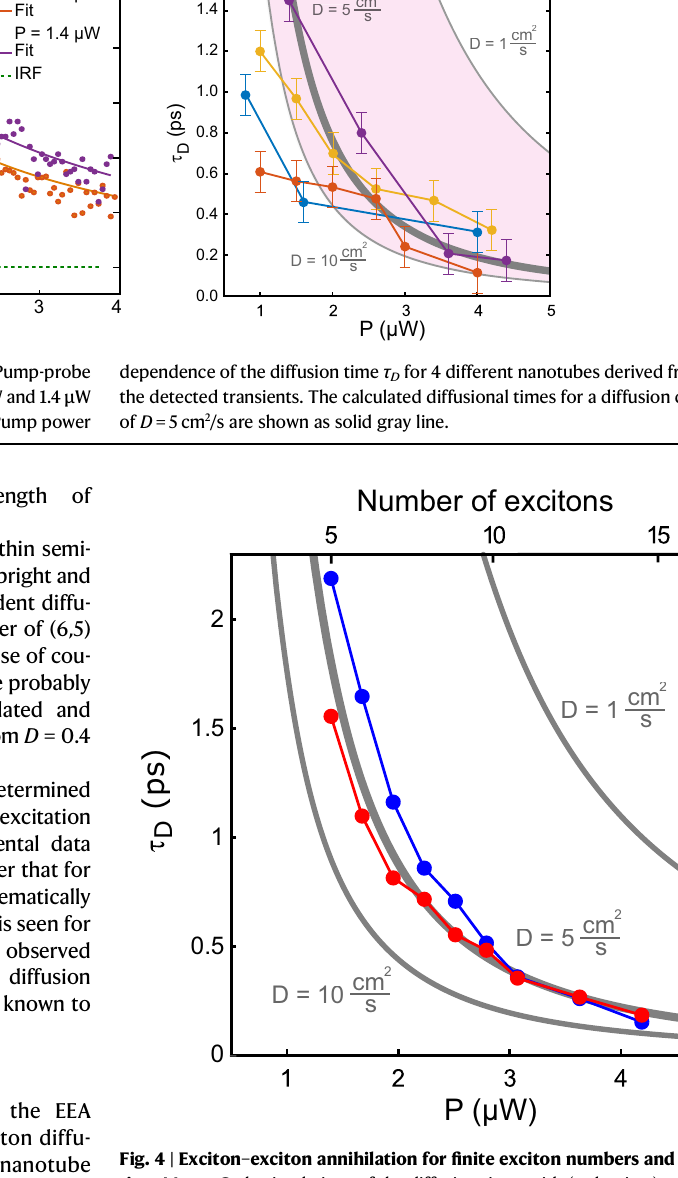
Fig. 4 | Exciton – exciton annihilation for fi nite exciton numbers and localiza- tion. Monte-Carlo simulations of the diffusion times with (red points) and without (blue points) exciton localization and a diffusion coef fi cient of D =5cm 2 /s. Analyti- callycalculateddiffusiontimesfor D =1,5and10cm 2 /sareshownassolidgraylines.